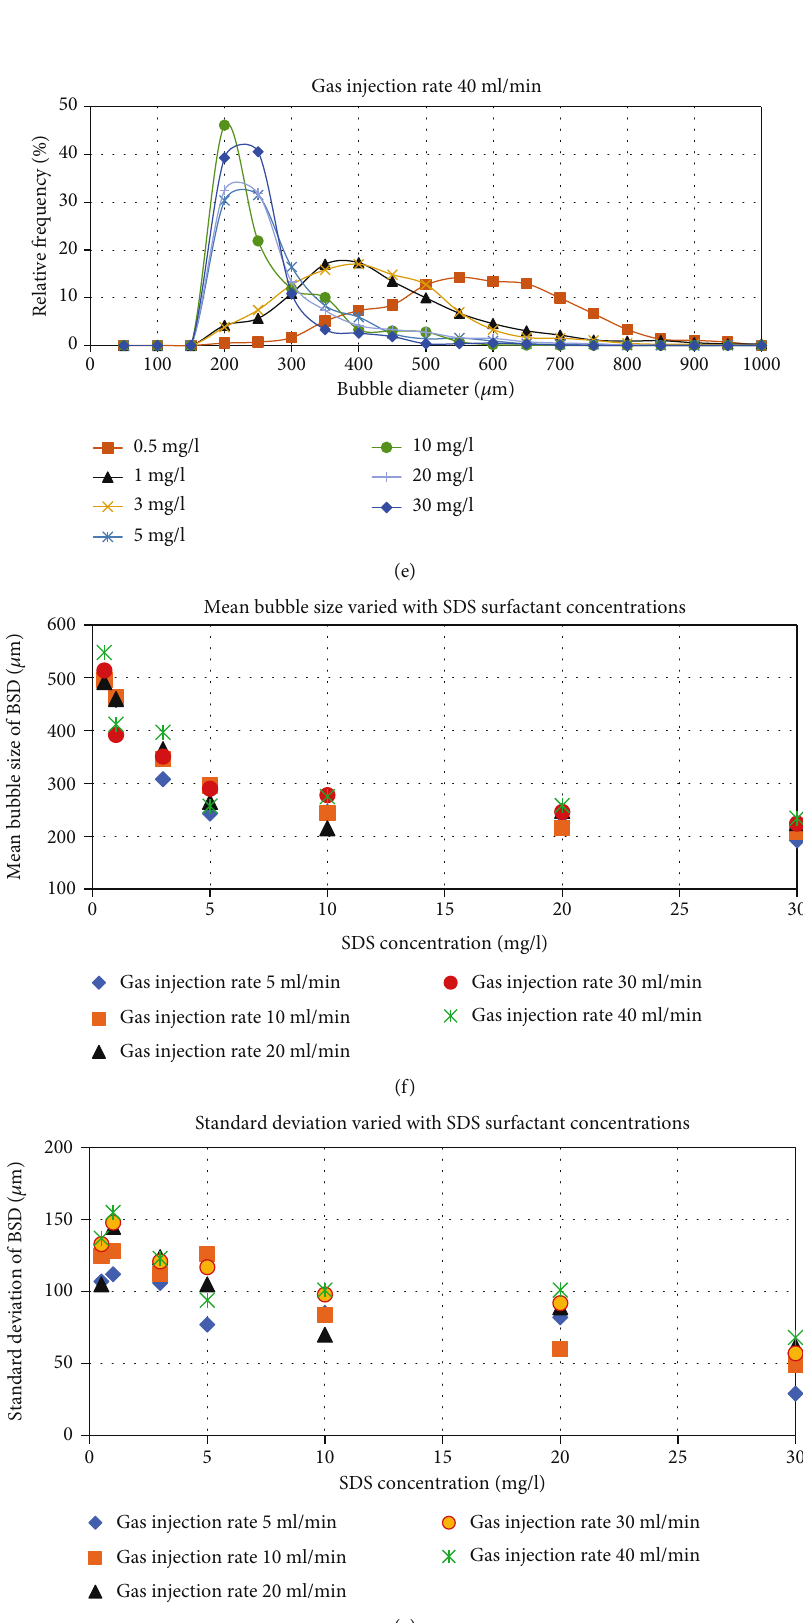
Figure 6: The e ff ects of sodium dodecyl sulphate (SDS) surfactant concentration on bubble size distribution (BSD) for fi ve di ff erent gas injection rates: (a) 5 ml/min, (b) 10ml/min, (c) 20 ml/min, (d) 30 ml/min, and (e) 40ml/min. (f) The linear mean bubble size of BSD varied with SDS surfactant concentrations. (g) The standard deviation (STD) of BSD varied with surfactant